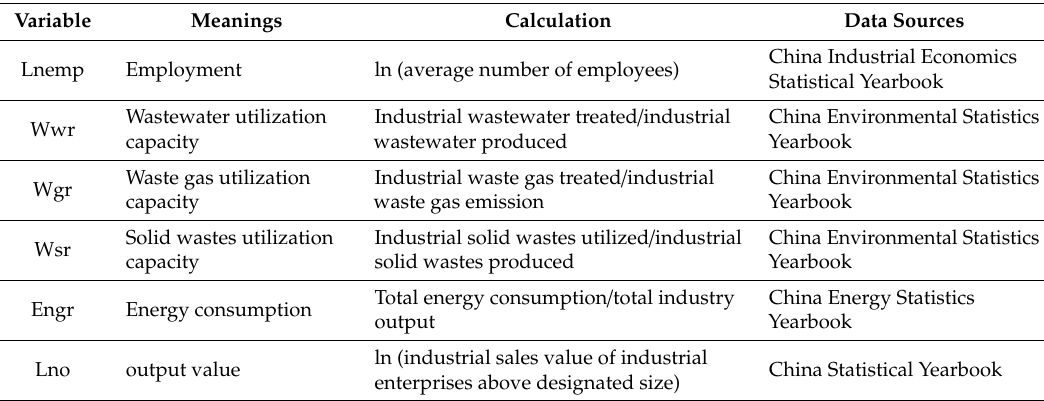
Table 1. Variable meanings and data